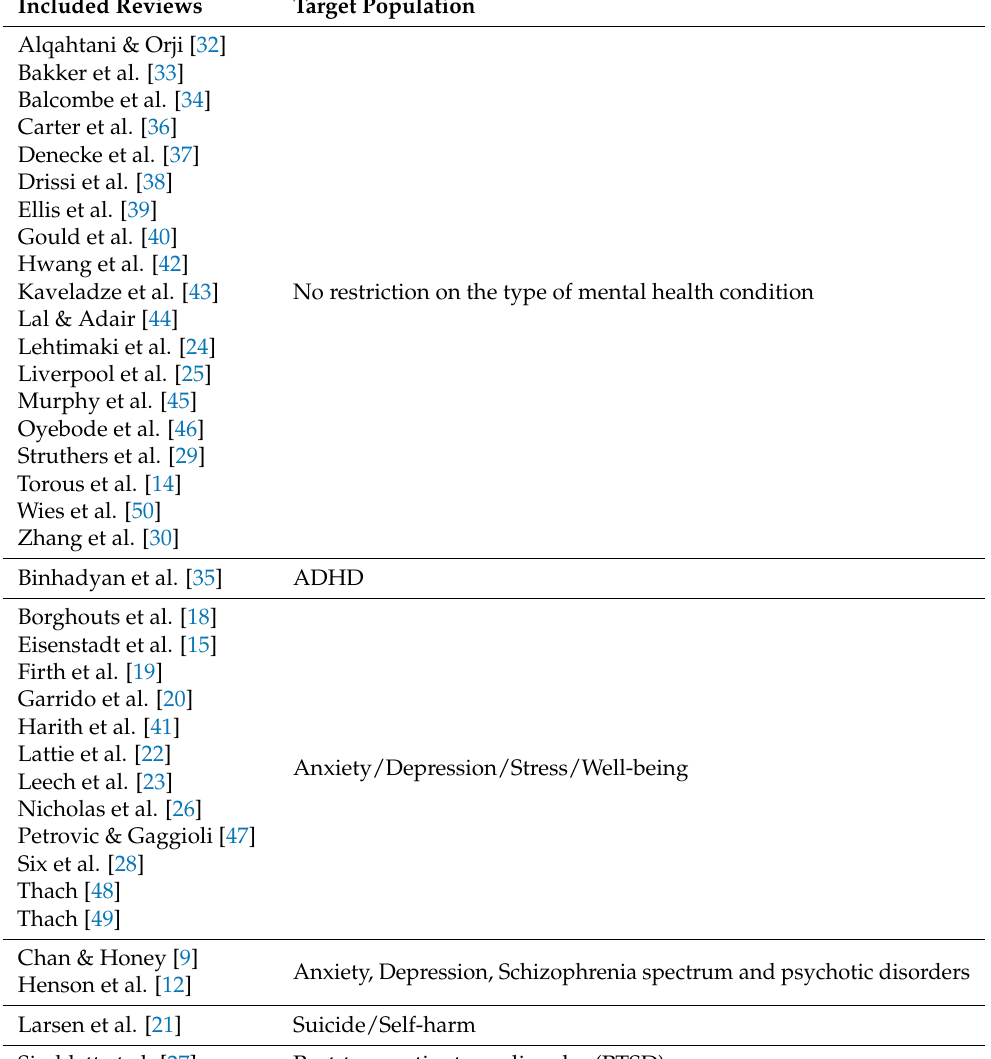
Table 3. Target population of included